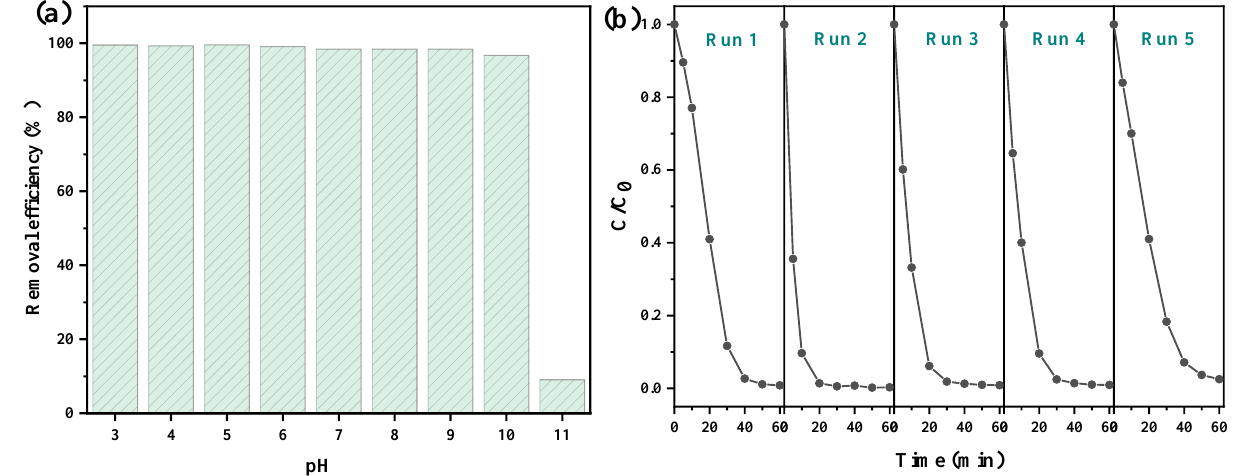
Figure 6. The catalytic performance of CS-Fe-2 ( a ) under different pH values and ( b ) in recycle use at neutral pH values (AR 73: 50 mg/L; CS-Fe-2 dosage: 1 g/L; H 2 O 2 dosage:20 mM; time: 60 min). The stability of recycling is a vital factor for evaluating a catalyst’s performance. After the reactions, CS-Fe-2 was collected by centrifugation and drying, and then used for an- other cycle. In Figure 6b, there was only a 1.7% decay in the AR 73 removal efficiency after five cycles, indicating the excellent stability of the catalyst. The chemical structure of the used catalyst was studied by XPS, and the results are presented in Figure S3 and S4. The survey and Fe 2p spectra showed only slight changes, but the Fe contents (Table S1) in- creased from 2.49 at% to 2.97 at% after the reaction. The peaks of C–S 2p 3/2 and SO 42 − 2p 3/2 in the S 2p spectra shifted visibly towards the lower binding energies. In addition, the area ratio of the fitted SO 42 − 2p 3/2 peaks to S 22 − increased from 0.38 to 0.89 after the reaction. These results demonstrate that the surface S atoms were partly oxidized to SO 42 − by H 2 O 2 and other ROS, or due to inner electron transfer from reductive S to Fe 3+ , which could